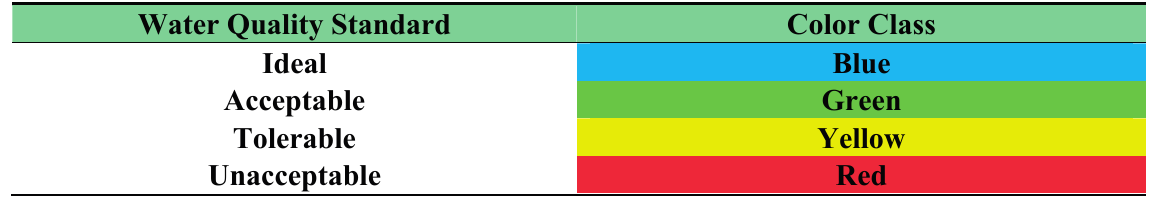
Table 1. Applied color classification of water quality